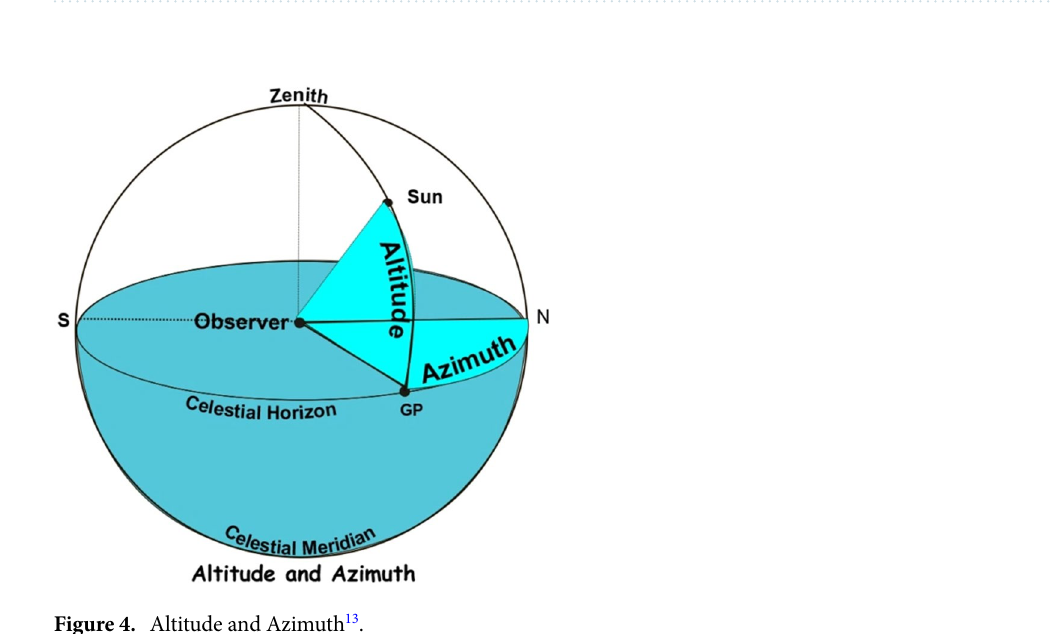
Figure 3. The relative positions of the Moon and Sun and parameters used in the crescent Moon visibility prediction.